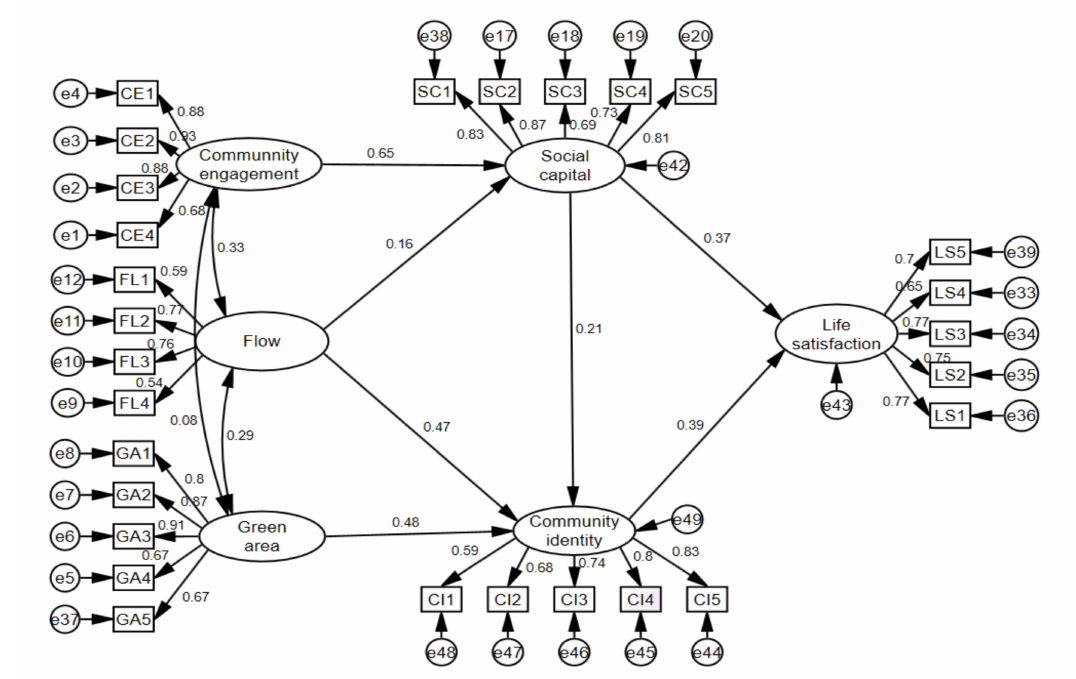
Figure 6. Results of the validated